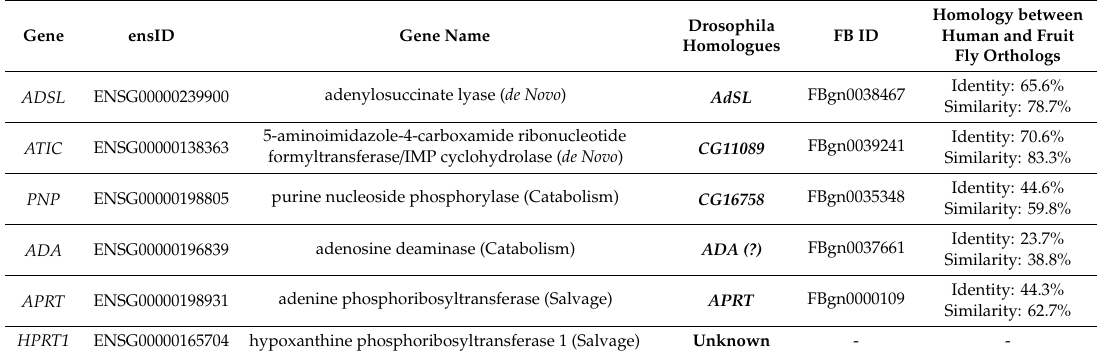
Figure S1: Phylogenetic tree of PRPS and PRPS -binding proteins (PAP) across species. Phylogenetic relationships of PRPS homologs across species were estimated using PhylomeDB (http: // phylomedb.org / ). Red indicates duplication events. Blue indicates speciation events. Green dot marks the target sequence, human PRPS1 . Q9VT33 is the only Drosophila PRPS ortholog. PRPS -associated protein 1 and 2 (PRPPSAP1 and PRPPSAP2) are orthologues of human PAP39 and PAP41, respectively. Conserved domains of PRPS -family are shown in the right